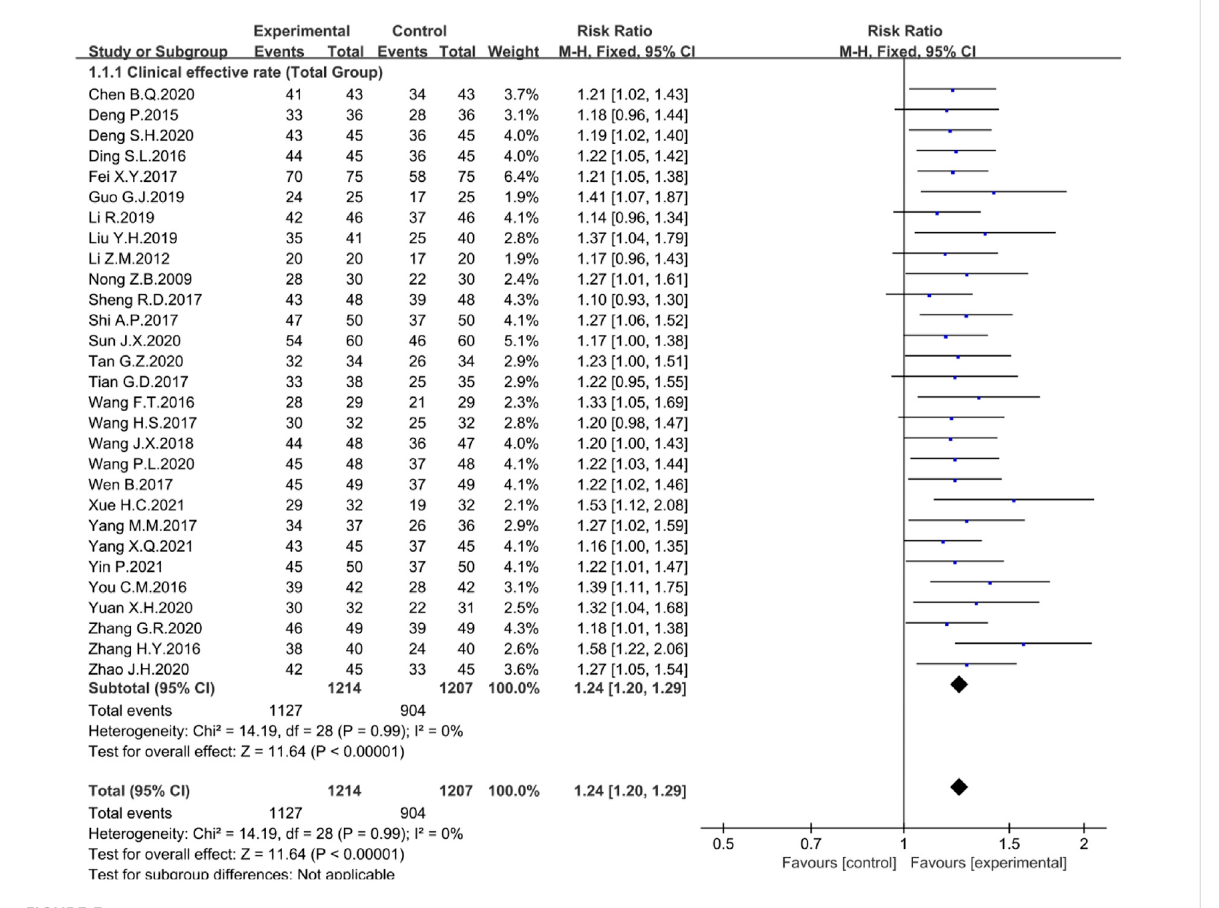
FIGURE 3 Forest plot displaying the Meta-analysis results for clinical ef fi